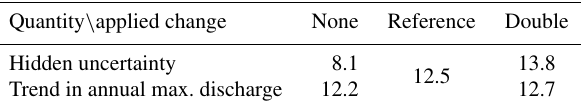
Table 3. Recommended planning margin (%) when using five ef- fective projections and varying hidden uncertainty and